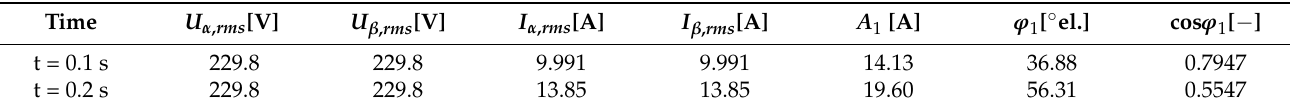
Table 3. Simulation results before and after the change (at steady states).